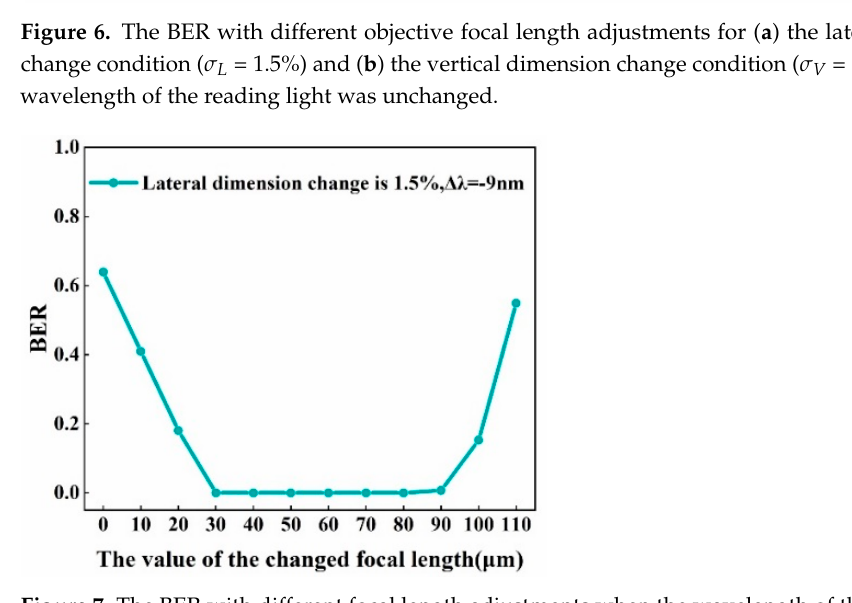
Figure 7. The BER with different focal length adjustments when the wavelength of the reading light was reduced by 9 nm and σ L was 1.5%.